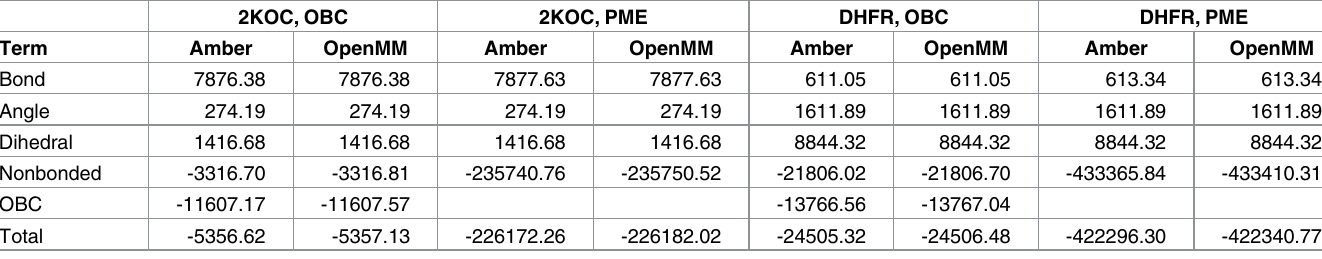
Table 6. Comparison of energy components, as calculated by Amber and